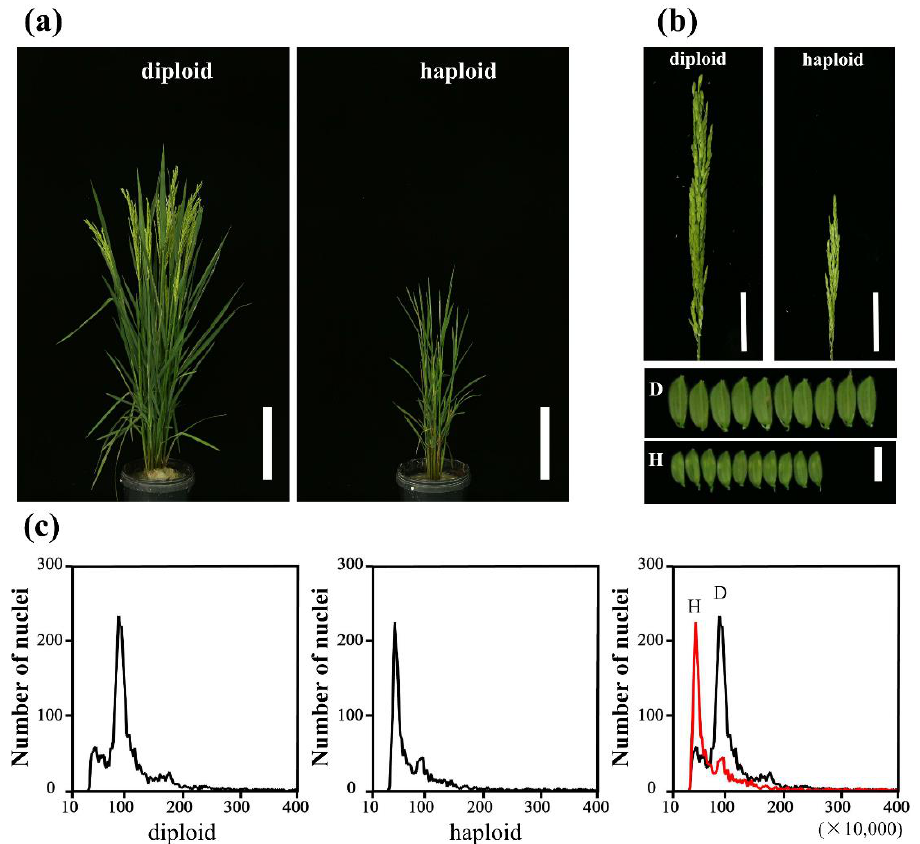
Figure 5. Characterization of a rice haploid line. ( a ) Whole plants of diploid and haploid rice. ( b ) Panicles and glumes of diploid and haploid rice. Bar = 20 cm ( a ), 3 cm (( b ), upper panel) and 2 cm (( b ), lower panel). ( c ) Ploidy analysis of diploid (D; black) and haploid (H; red) lines by flow cytometry. The haploid lines were generated by crossing ZhongguangA with mtl haploid inducers. Plants were grown in Hangzhou, China. Table 1. Seed-setting rate and haploid induction rate of selected mtl haploid inducers in Hangzhou.